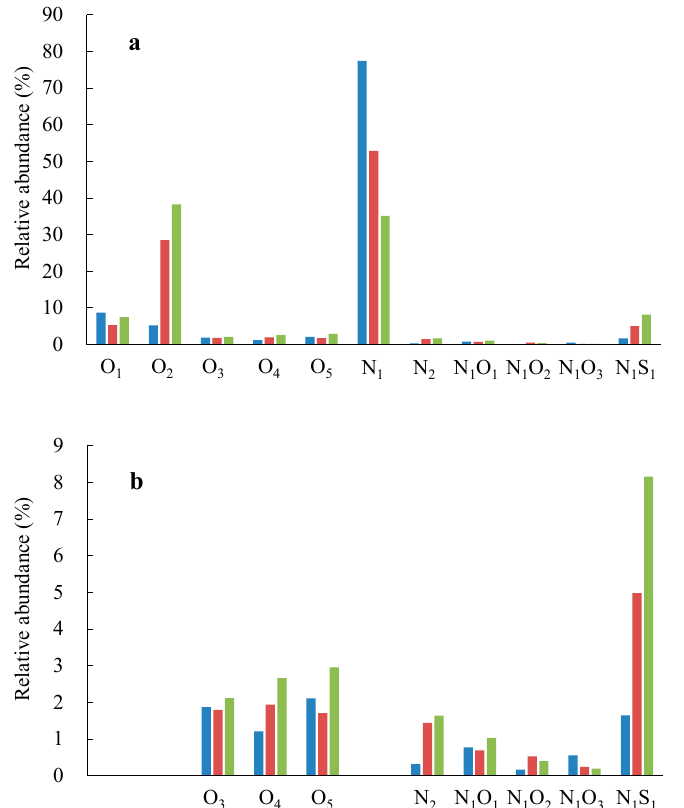
Figure 3. Bar graphs showing the relative abundance of heteroatomic classes assigned from the negative-ion ESI Orbitrap mass spectra of the studied crude oils with increasing biodegradation: (a) all the twelve heteroatomic classes; (b) the classes with low abundance.